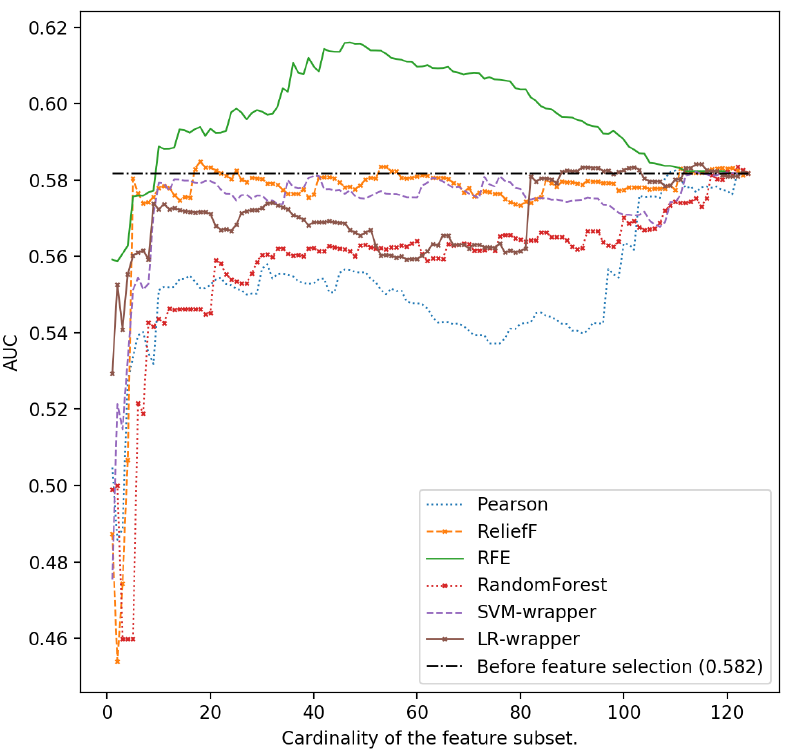
Figure 3. Area under the curve using the complete data set without reducing features and different cardinality of the subset of features for different classifiers: Logistic